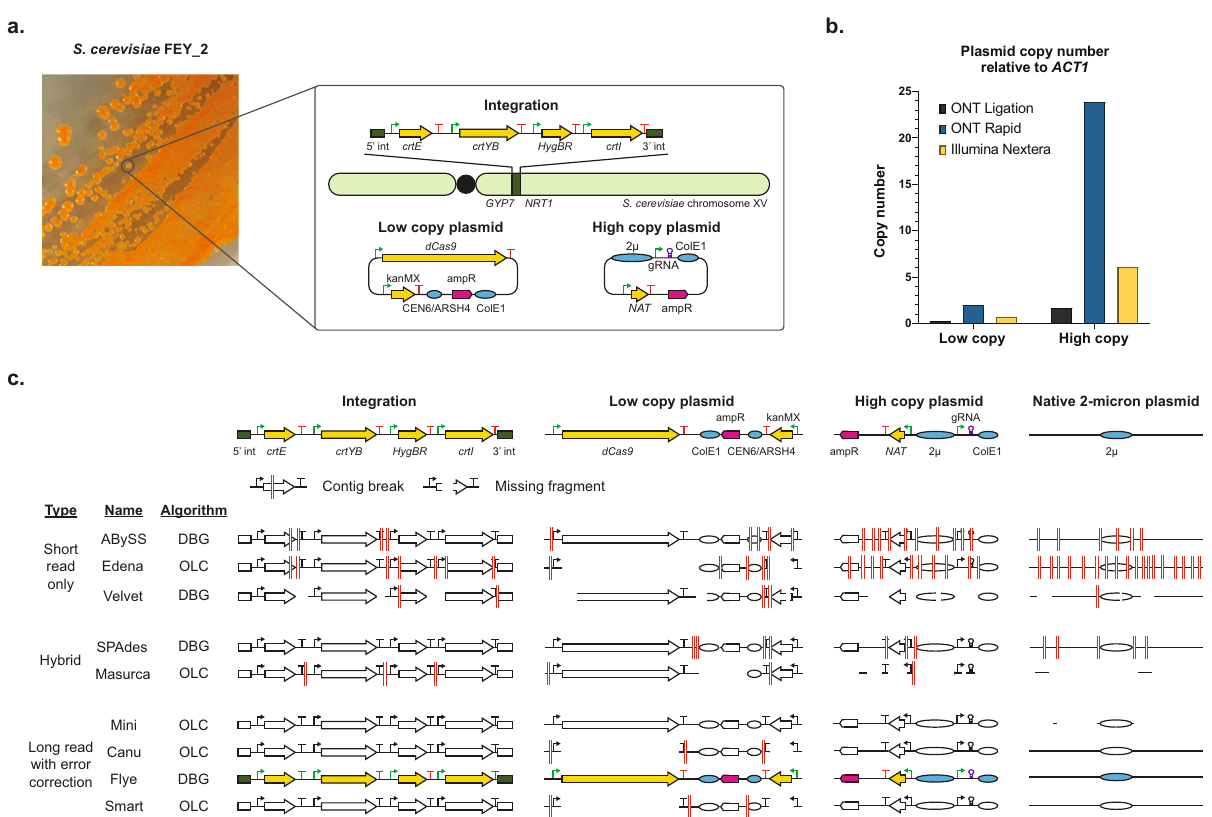
Fig. 1 Detection of engineering signatures in S. cerevisiae FEY_2. a Photograph of FEY_2 streaked onto an agar plate, showing a functional carotenoid pathway. The illustration shows the engineering signatures comprising FEY_2, which included a carotenoid pathway chromosomal integration, a low copy plasmid expressing dCas9, and a high copy plasmid expressing gRNA. b Approximate copy number from genomic DNA libraries prepared by Oxford Nanopore Technologies ’ (ONT) Ligation and Rapid kit and Illumina ’ s Nextera kit for the low copy and high copy plasmids in FEY_2. c BLASTN results from querying known engineering signatures against assemblies. The genome assemblers were categorized as short-read only, hybrid, or long read with error correction. The underlying algorithm type of each assembler, De Bruijn graph (DBG) or overlap-layour-consensus (OLC), is also shown. Failure modes of genome assemblies were shown as red lines (contig break) and white spaces (missing fragment). The colored pathways and plasmids represent assemblies where all engineering signatures were found in contiguous